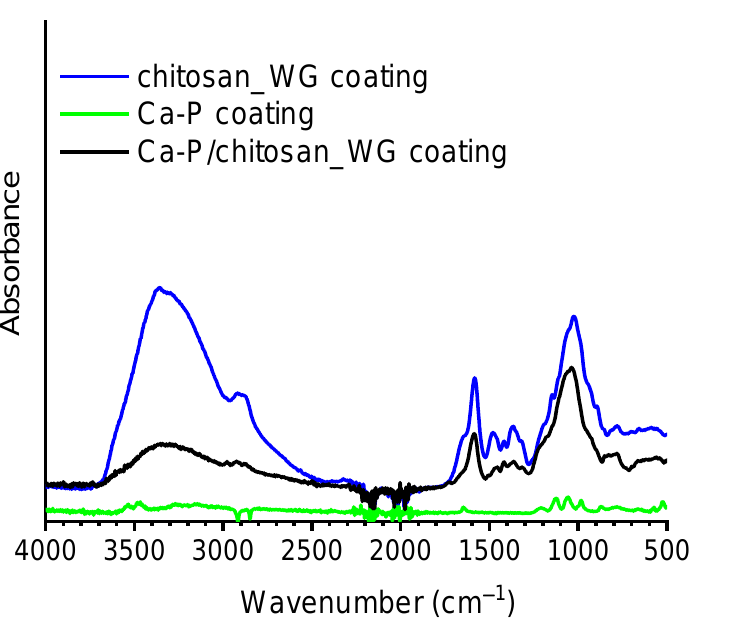
Figure 3. FT-IR spectra of the different coatings. The relevant bands are described in the text.